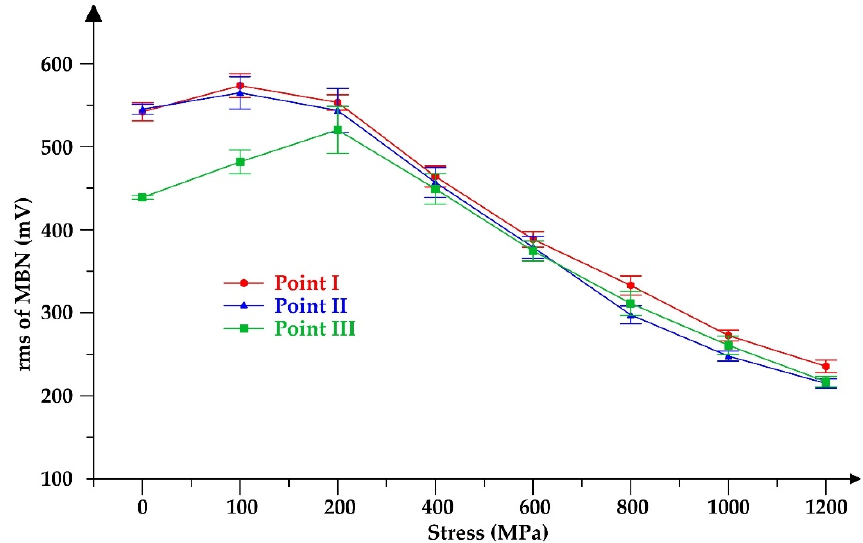
Figure 14. MBN as a function of stress (Specimen 4; Wire 1).